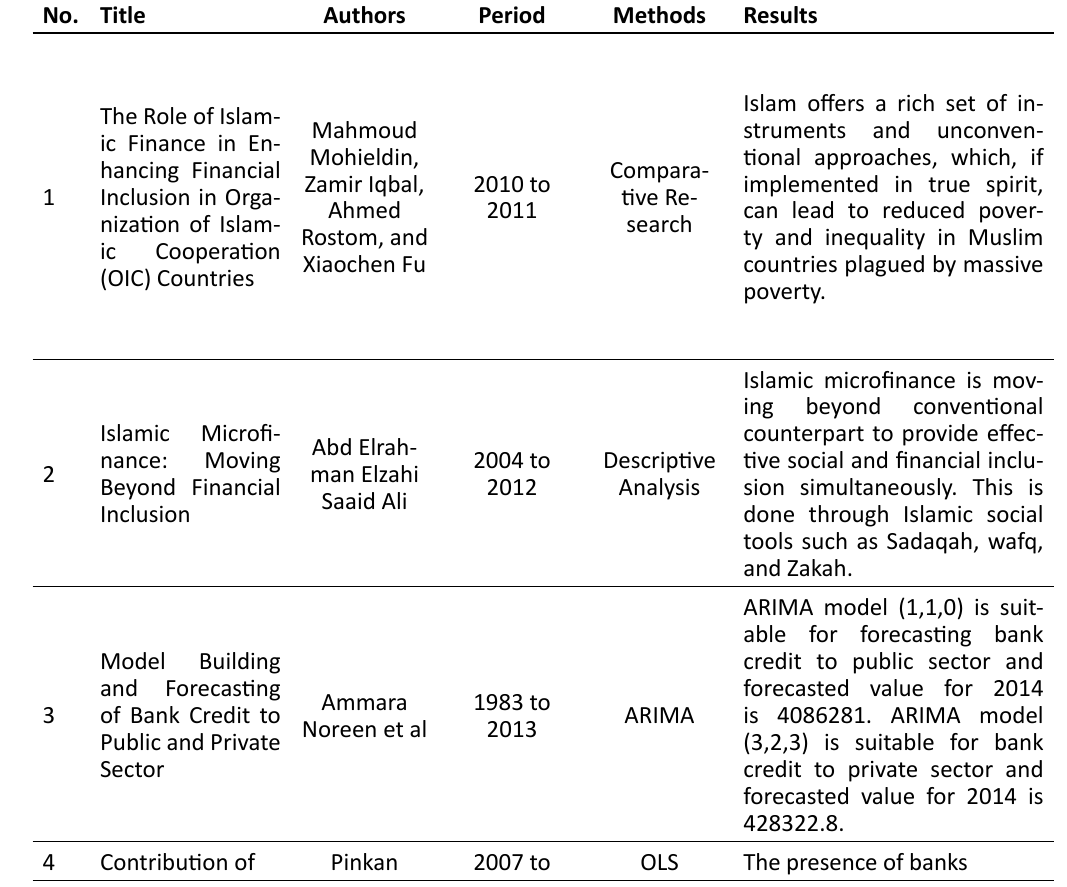
Table 1: Previous Research Related to Financial Inclusion through Microfinance Institutions No.